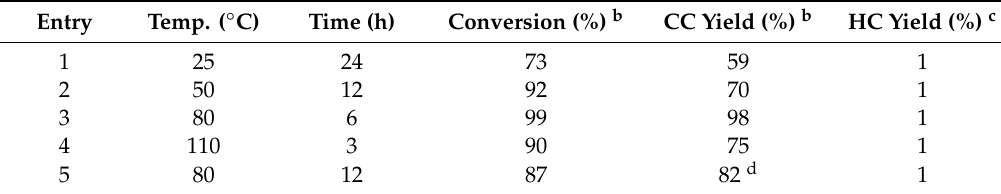
Table 2. Temperature e ff ect on the model SM cross-coupling reaction using ligand 2a . a